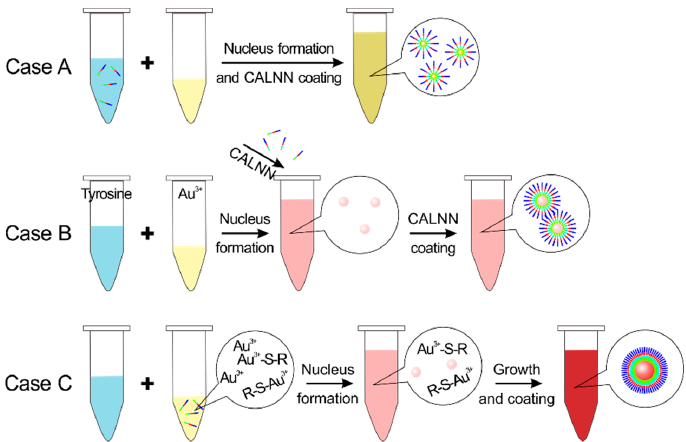
Figure 2. Schematic illustration of the formation of AuNPs by the three different routes.